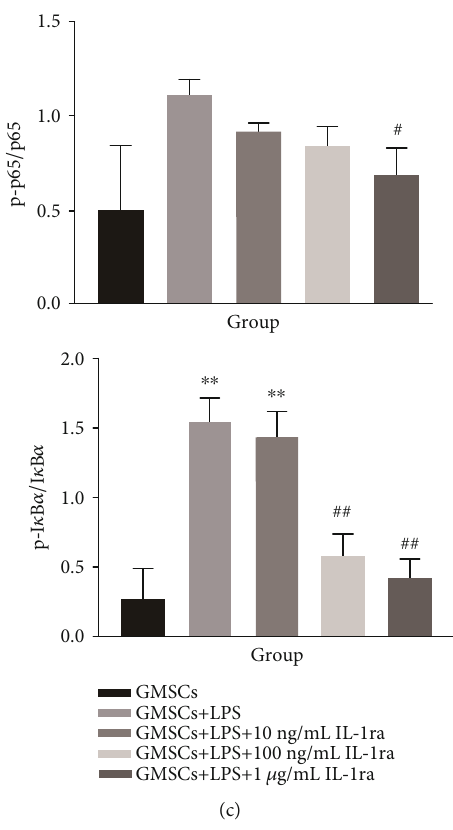
Figure 9: IL-1ra attenuates the P. gingivalis -LPS-activated TLR4-mediated NF- κ B pathway in rGMSCs. RT-PCR and western blot analysis were performed. (a) mRNA expressions of TLR4 and I κ B α were analyzed by RT-PCR at 1, 7, and 14 days. (b) Protein expressions of phosphorylated I κ B α , I κ B α , NF- κ B phosphorylated p65, and NF- κ B p65 after 1-hour induction in di ff erent groups (G1: GMSCs; G2: GMSCs+LPS; G3: GMSCs+LPS+10ng/mL IL-1ra; G4: GMSCs+LPS+100 ng/mL IL-1ra; and G5: GMSCs+LPS+1 μ g/mL IL-1ra). (c) The ratio of p-I κ B α /I κ B α and NF- κ B p-p65/p65 in di ff erent groups. ∗ P < 0 : 05 , ∗∗ P < 0 : 01 , and ∗∗∗ P < 0 : 001 vs. GMSCs; # P < 0 : 05 , ## P < 0 : 01 , and ### P < 0 : 001 vs.